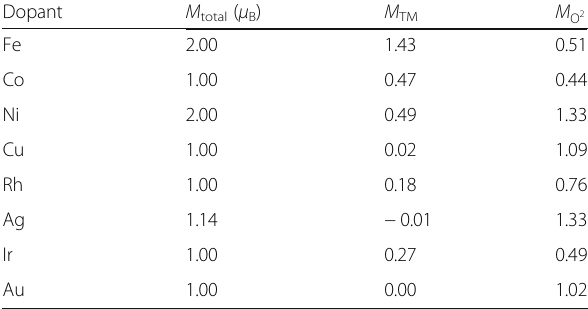
Table 3 Calculated total magnetic moment ( M total ) of O 2 -(TM- phosphorene) systems. The magnetic moments of impurity atoms ( M TM ) and an oxygen molecule ( M comparison